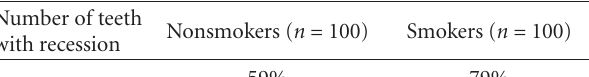
Table 7: Comparison of recession between nonsmokers and smokers.